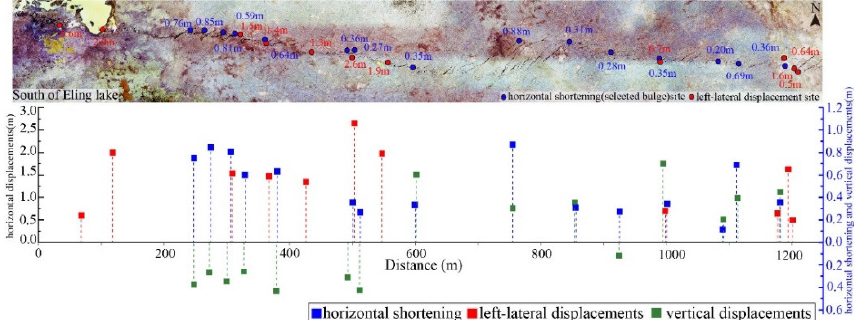
Figure 12. The distribution of horizontal shortening (calculated from the bulges), left-lateral displace- ments, and vertical displacements along the west of the south Eling Lake segment.